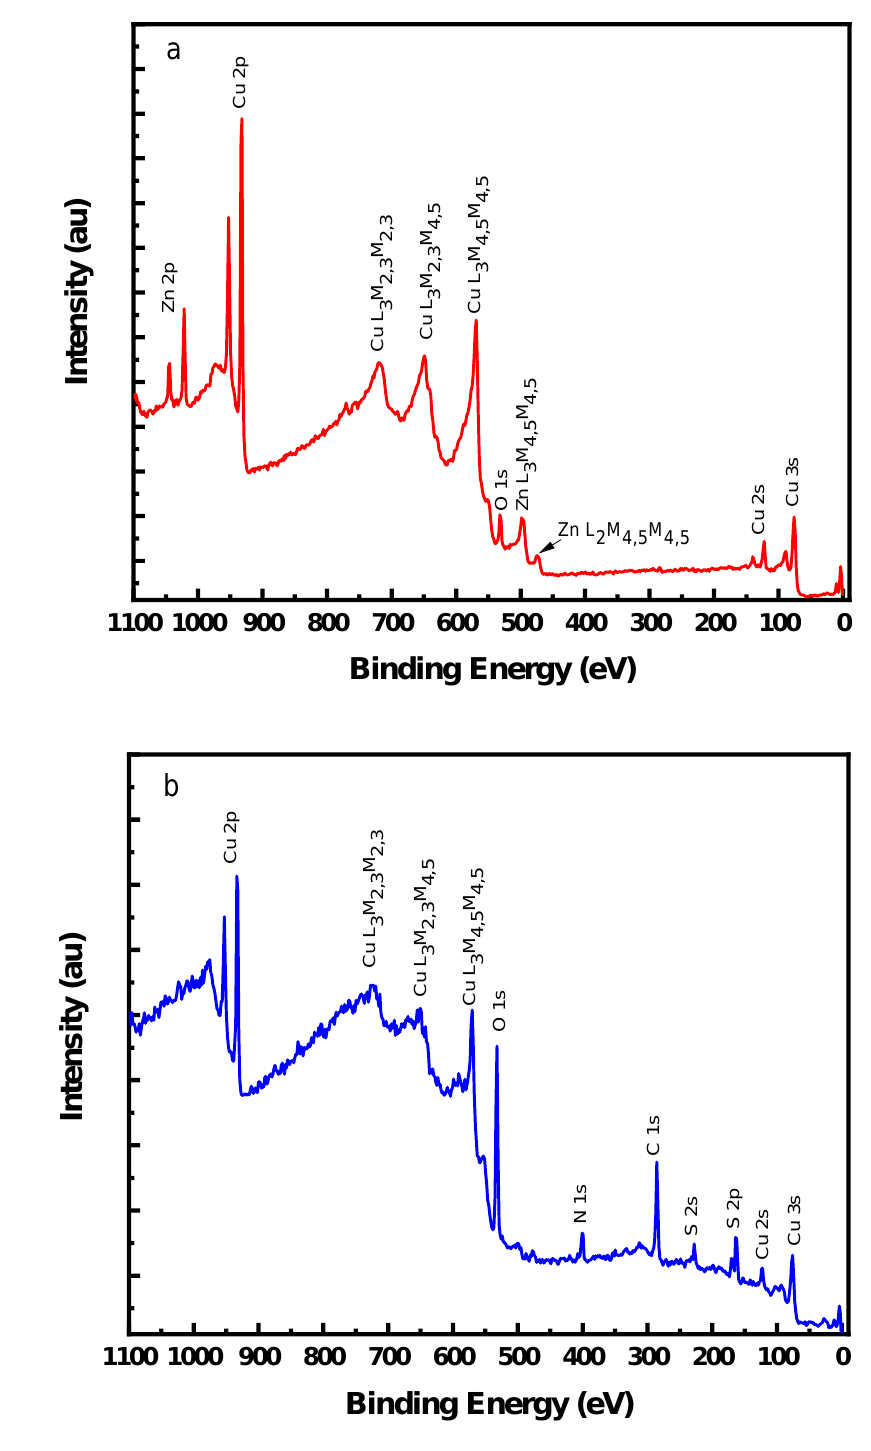
of 168.3 eV (S 2p 3/2 ) can be assigned to adsorption of sulfate from the bulk solution.